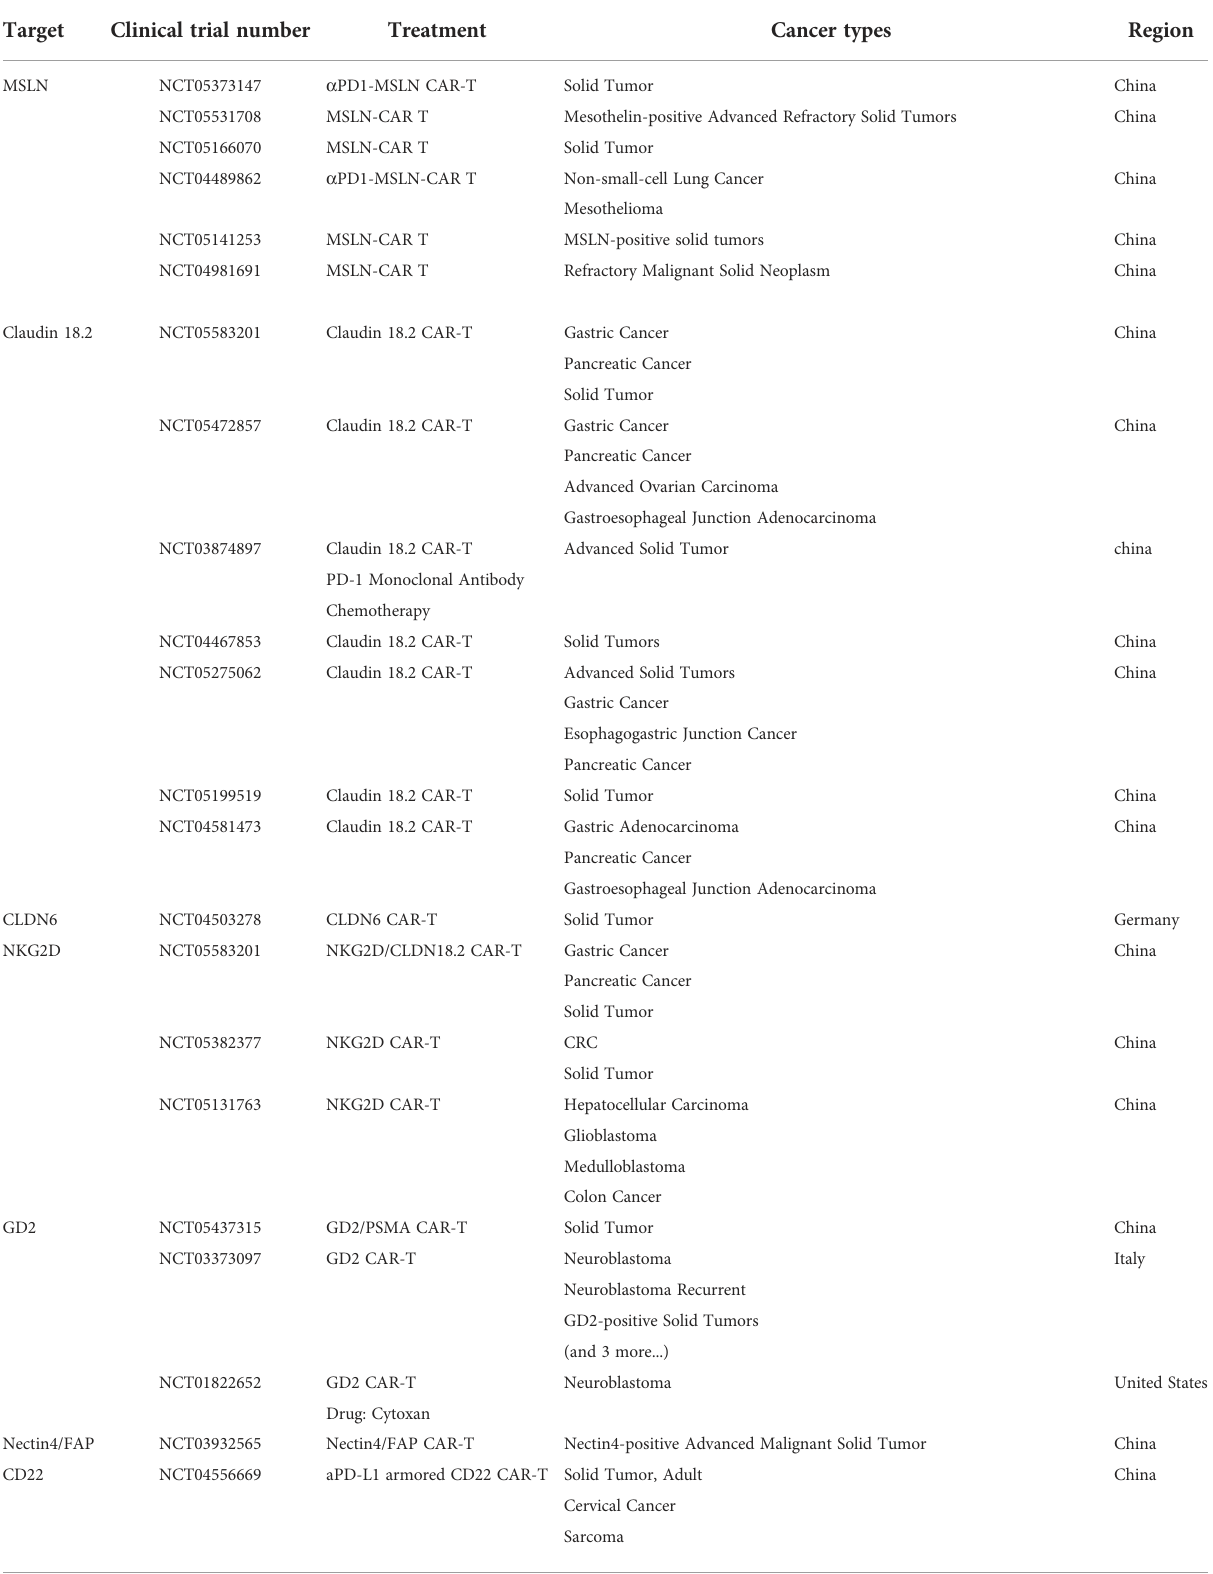
TABLE 1 Current ongoing CAR T therapy clinical trials in solid